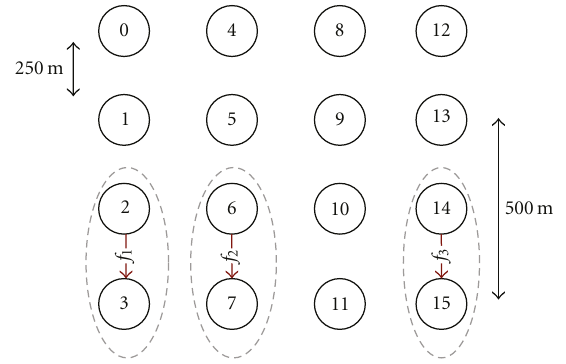
Figure 1: 4 × 4 Grid simulation topology. three flows, 1: (2-3), 2: (6-7), 3: (14-15), are